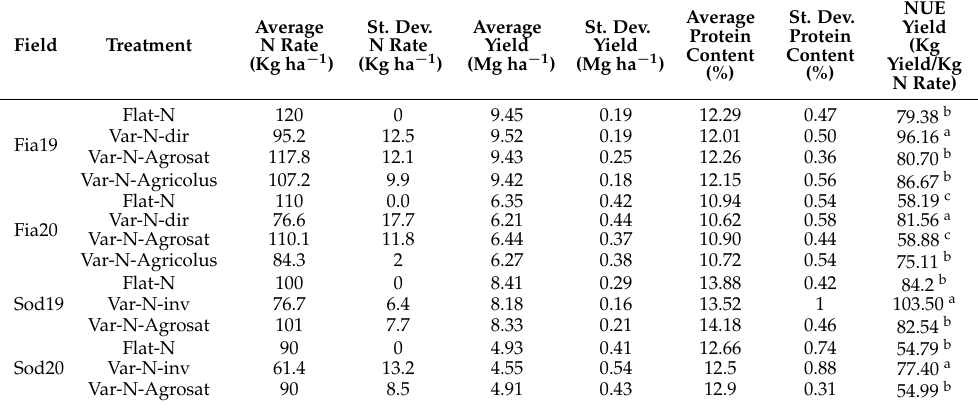
supplied. Var ‐ N ‐ inv and Var ‐ N ‐ dir showed the highest NUE ( p ‐ value < 0.05), followed by Var ‐ N ‐ Agricolus and then by Flat ‐ N and Var ‐ N ‐ Agrosat, which did not differ substantially. The high variability in Var ‐ N ‐ Agricolus for Fia19 accounted for the lack of significant differences between Var ‐ N ‐ Agrosat and Flat ‐ N. No significant differences were recorded for protein content, whose range for all treatments within the same field was in the order of 0.5% or less. Table 6. Resume data of all treatments for each field. Average and St. Dev. N rates refer only to the second fertilization. a–c : homogenous grouping of means based on Tukey’s HSD post ‐ hoc test (the test was carried out separately for each field).